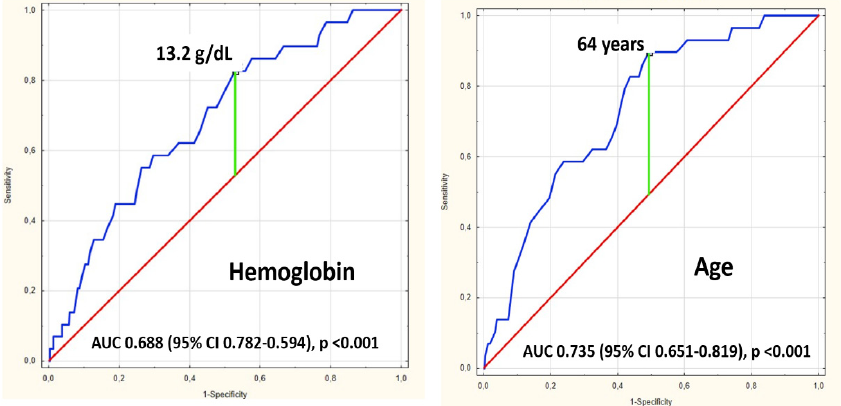
Figure 1. Receiver Operator Characteristics of haemoglobin concentration at admission and age of 2 year mortality in 402 PE survivors. AUC Area under the curve, CI—confidence interval. Using ROC curve we selected 2 cut-off point values of hemoglobin level. A group of